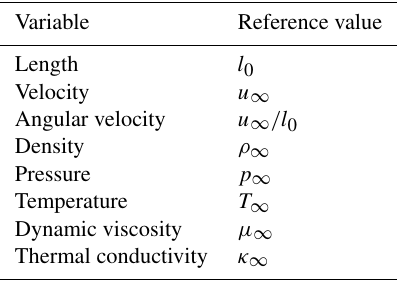
Table 1. Reference values. ∞ denotes freestream